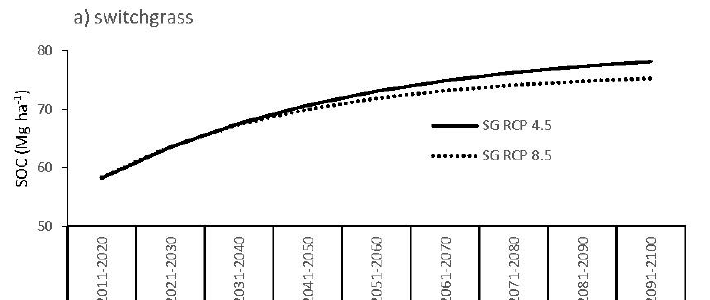
10 of 16 Figure 5. DayCent predicted average SOC sequestration rate over the entire simulation period (2009- 2100). SG 4.5 = switchgrass at RCP 4.5; SG 8.5 = switchgrass at RCP 8.5; MIS 4.5 = miscanthus at RCP 4.5; MIS 8.5 = miscanthus at RCP 8.5. Decadal SOC stock changes over the 21st century were fitted to non-linear regression lines (Figure 6). For a RCP 4.5 scenario, the best fit for switchgrass and miscanthus was described as